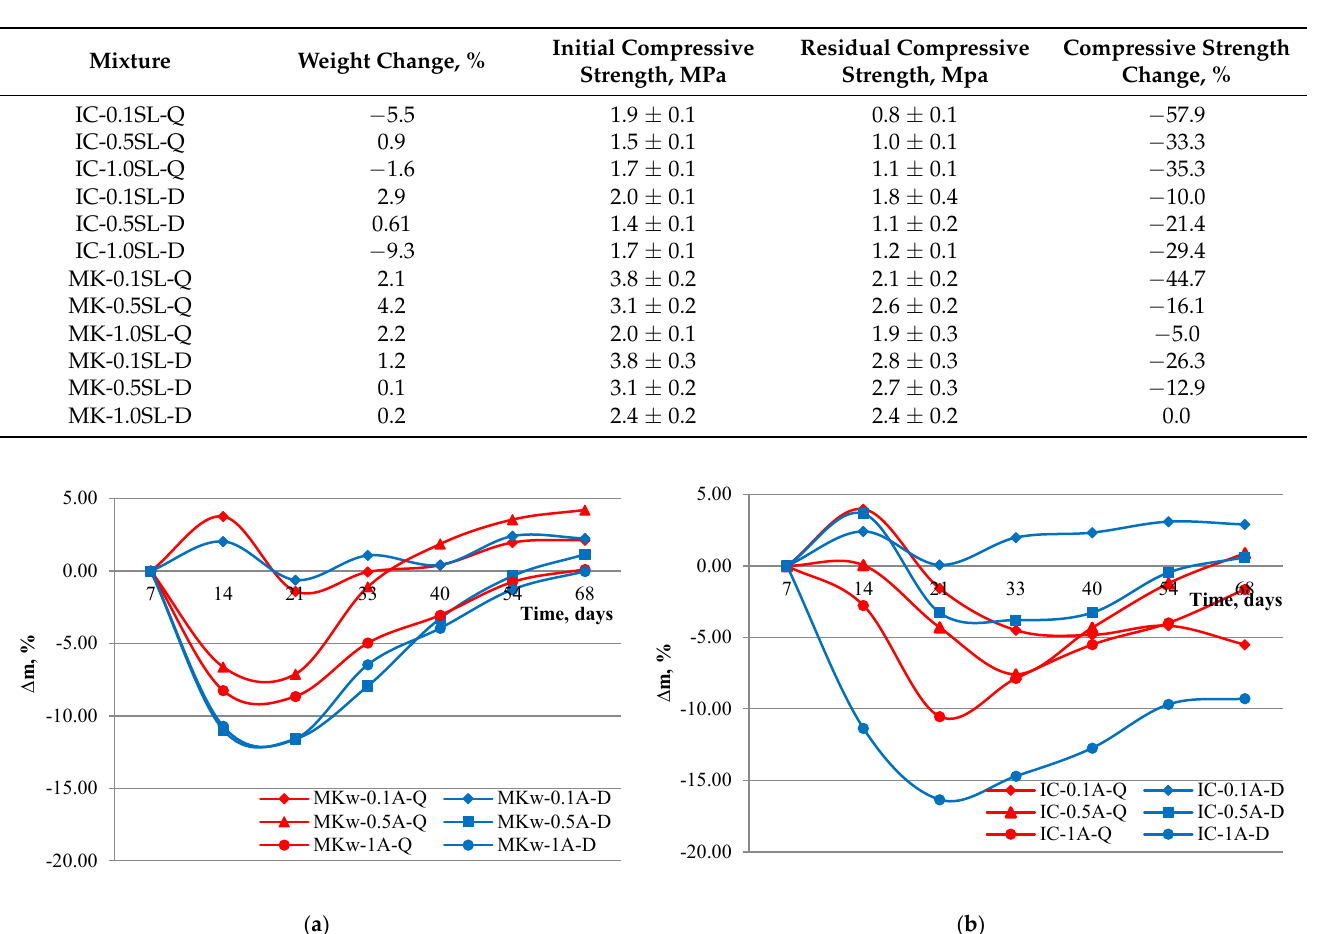
Table 5. Sulfate attack test results.